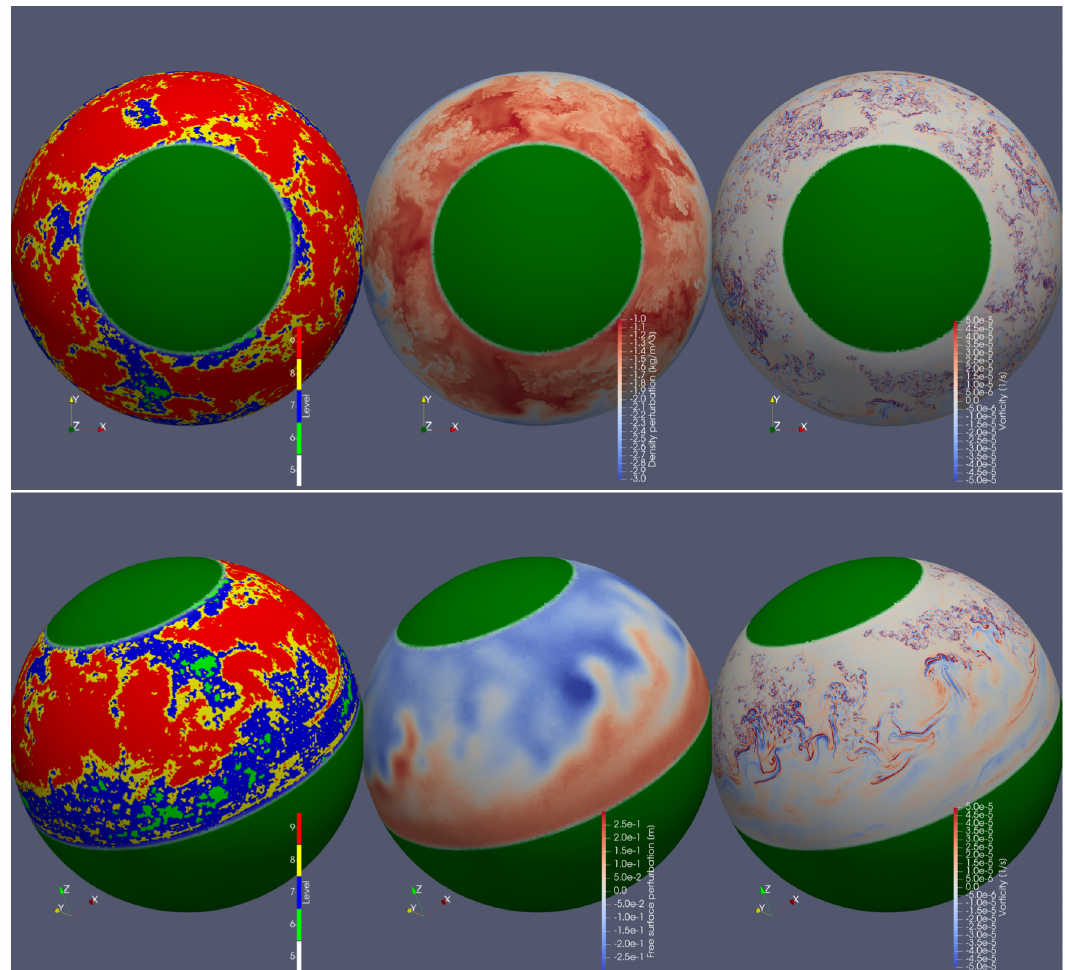
Figure 8. Results of the baroclinic jet test case at 600d near the surface at depth z = − 1 . 25m. The coarsest grid is (cid:49)x min ≈ 38km ( J = 5), and the finest grid is (cid:49)x min ≈ 2.1km ( J = 9), i.e. four levels of levels of local dyadic refinement. The tolerance is ε = 0 . 02. Top panel (left to right): adaptive grid, density perturbation, relative vorticity. Note that the green regions are the land mass, which are almost entirely at the coarsest level J min = 5, indicated by white in the leftmost figure. Bottom panel (left to right): adaptive grid, free surface perturbation, relative vorticity (note change in